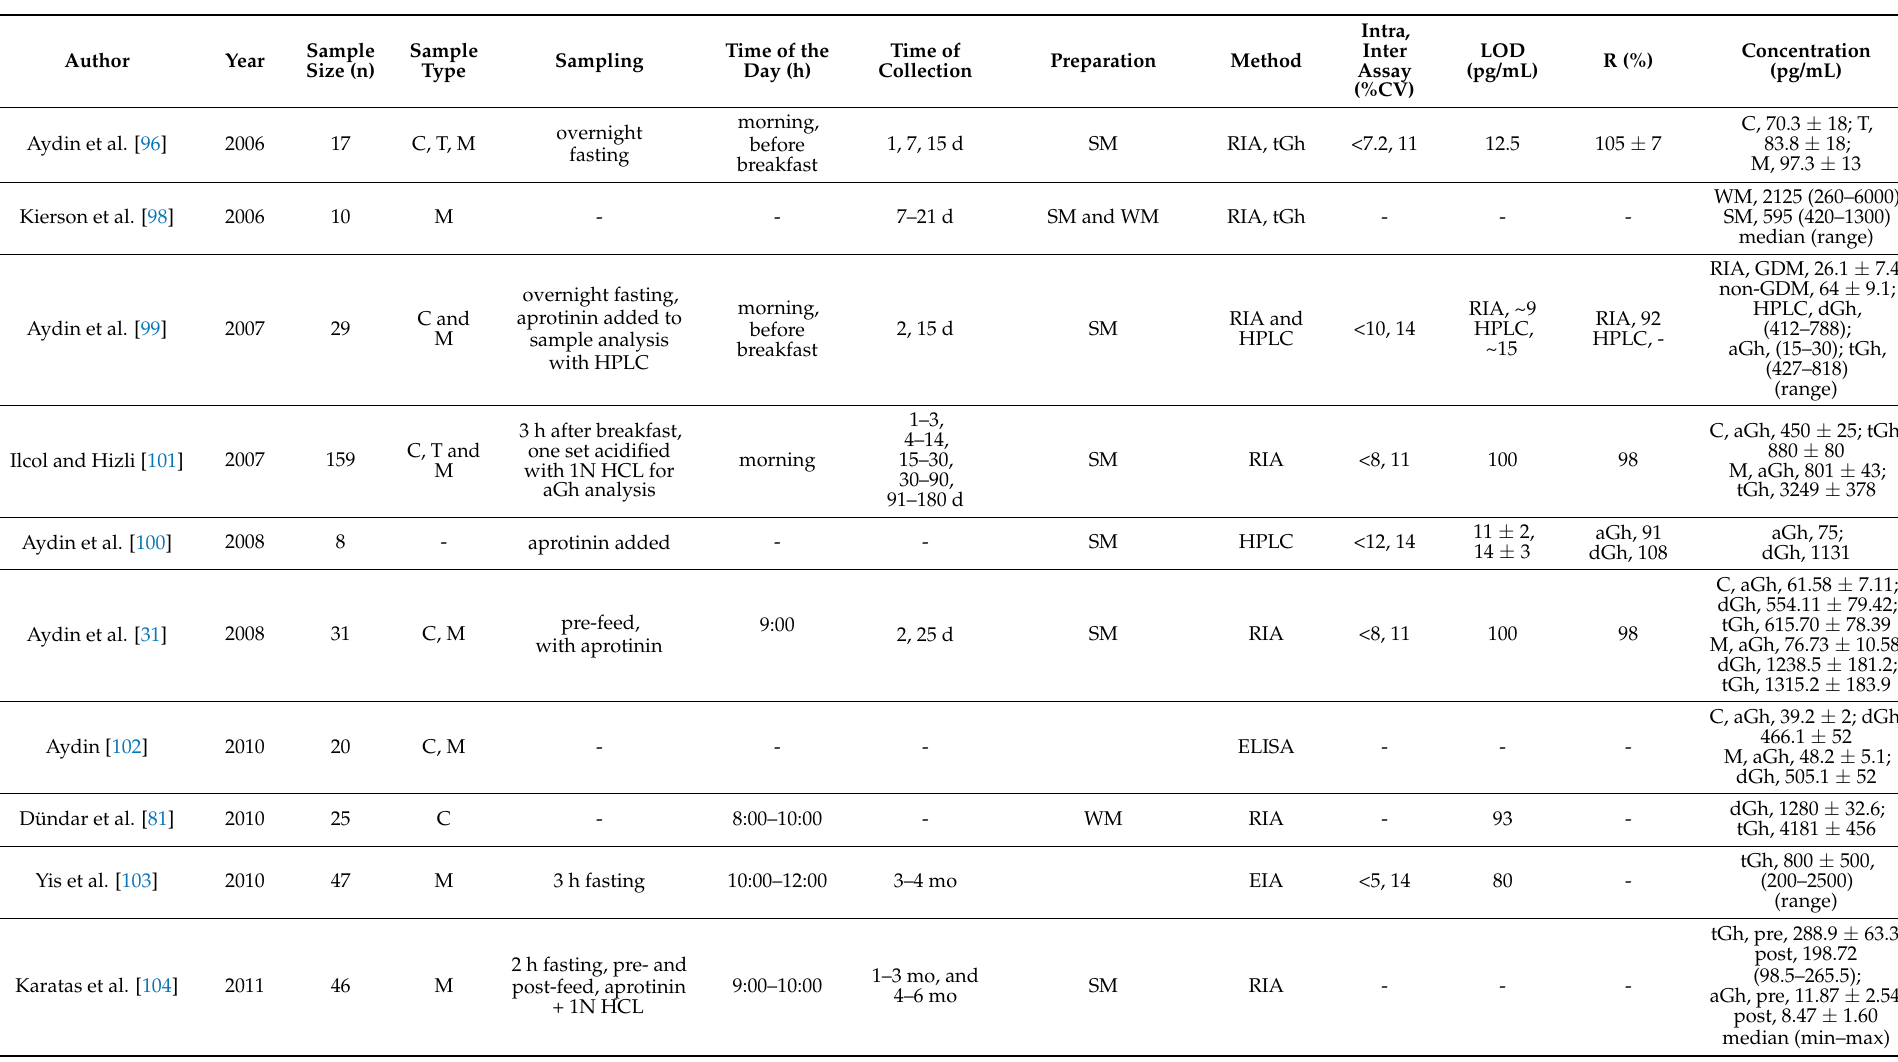
Table 3. Studies examining human milk